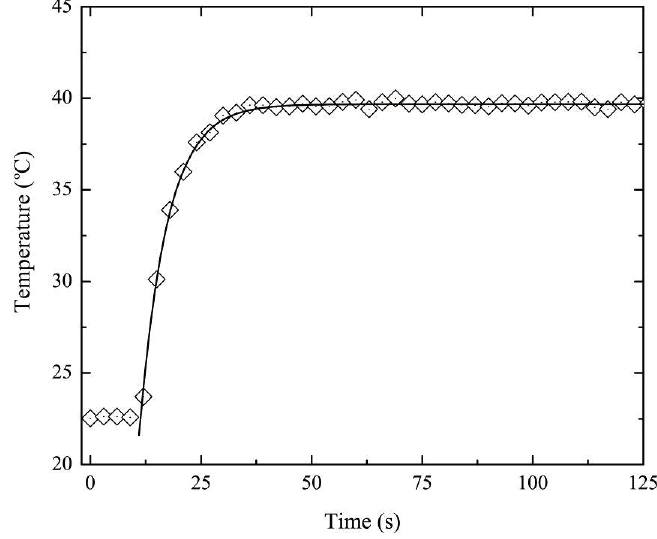
Figure 7. FBG based temperature sensor response as function of time when subjected to a temperate step: The diamonds show the experimental data and the line is the